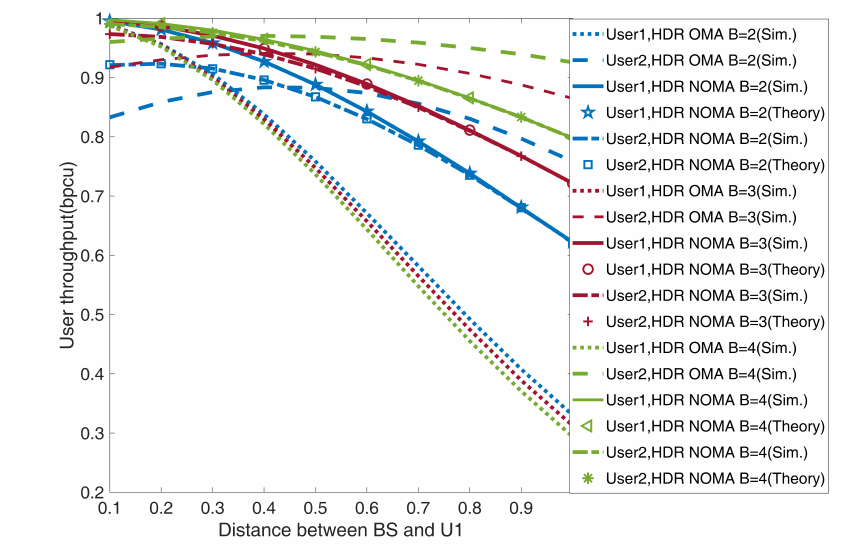
Figure 6. User throughput versus distance of U1, i.e., UAV from BS for UAV-HDR based-NOMA and OMA schemes in delay-limited transmission